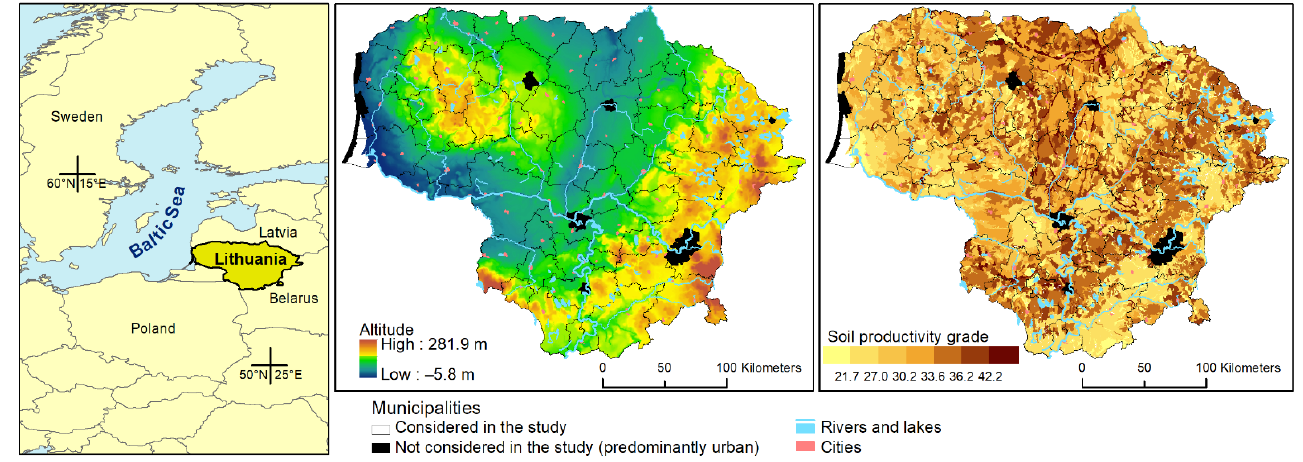
Figure 1. Specification of the study area: left —location of the study area in Europe, centre —elevation in Lithuania, right — average soil productivity grade. Sources of the data used: left —thematicmapping.org/downloads/world_borders.php (accessed on 13 May 2021), centre —GDB200 database from www.gis-centras.lt/ (accessed on 13 May 2021), right —derived using Dirv_DR10LT from www.geoportal.lt (accessed on 13 May 2021).